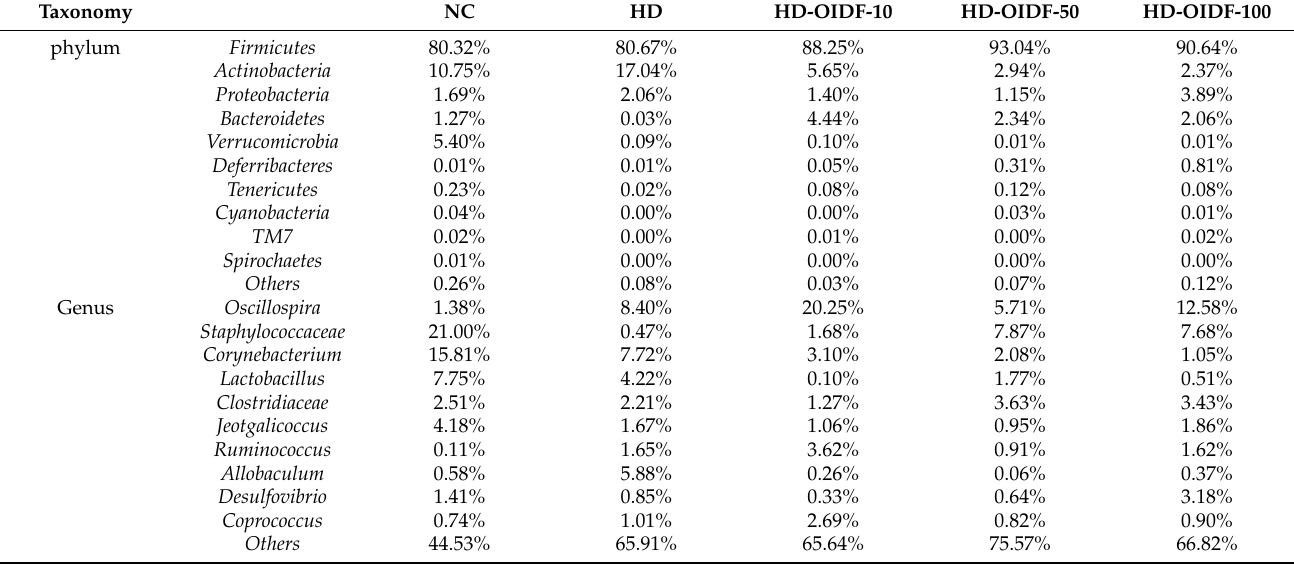
Table 3. Ratio of microbiota (top10) at the phylum and genus levels (%) ( n = 6).